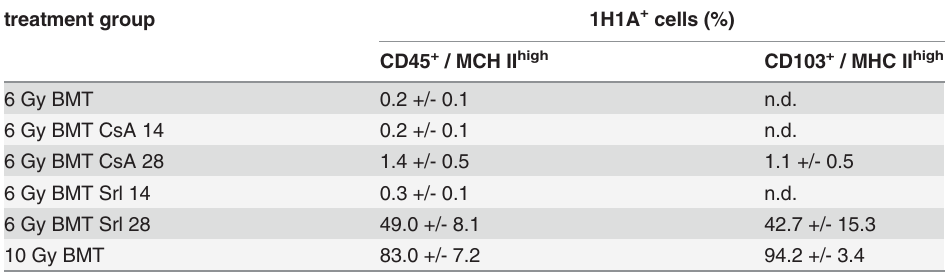
Table 3. Donor-derived fractions of MHC class II high cells in the thymus of BMT recipients at day 100. treatment group